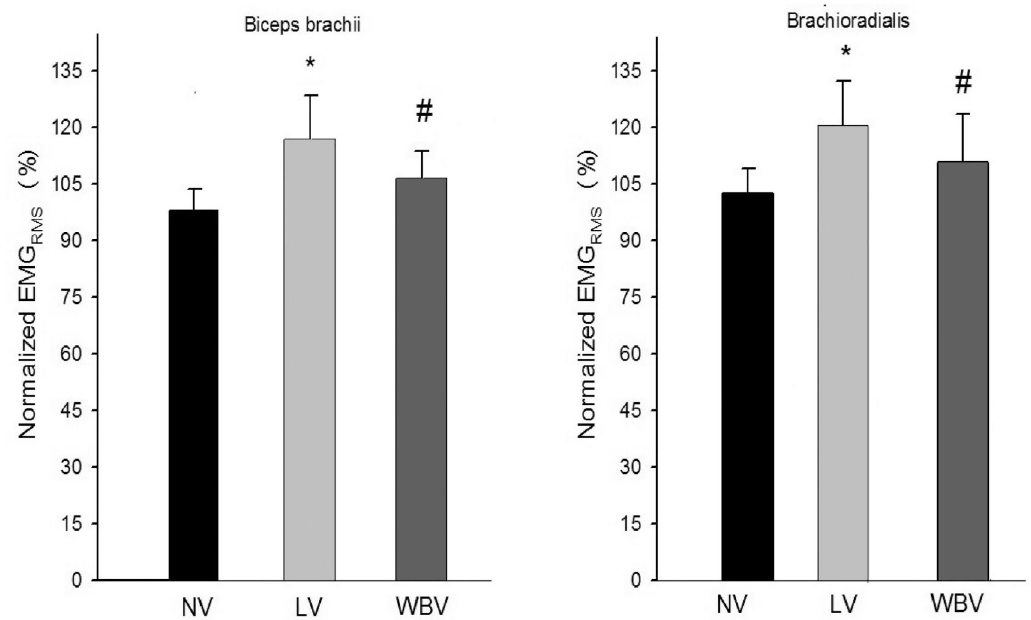
Figure 3 - Normalized EMG RMS of the brachii and brachioradialis biceps during the 1RM. NV = No vibration; LV = Local Vibration; WBV = whole- body vibration. Vertical lines = standard errors. *: Greater than NVand WBV. #: Greater than NV. Significance level at α < 0.05.